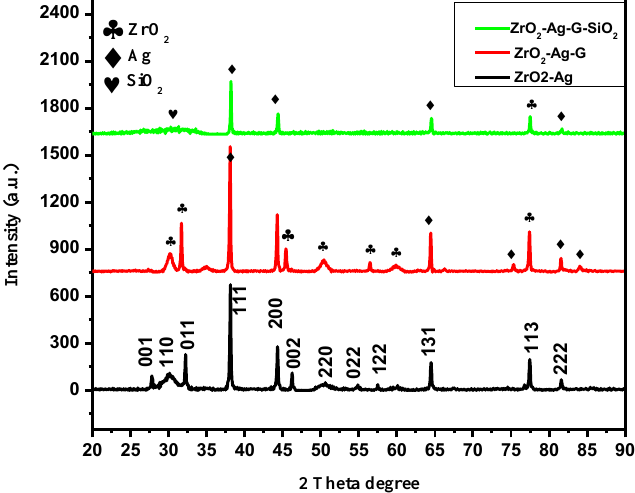
Figure 1. XRD patterns of ZrO 2 -Ag, ZrO 2 -Ag-G and ZrO 2 -Ag-G-SiO 2 . The XRD patterns of the nanoparticles give the major 2y peak values at 25.6, 30.2, 32.9, 38.5, 44.6, 46.2, 50.2, 54.5, 55.2, 63.8, 76.4, and 84.5 in accordance with monoclinic zirconia. All diffraction peak values matched with the international standard file (JCPDS 37-1484). After modification, Ag nanoparticles could be indexed based on pure silver ox- ide having the symmetry of face center cubic. The peaks designated to the planes with the hkl values of 38.5 (111), 63.8 (131), 74.39 (220), and 80.58 (311), respectively, are the same with the XRD pattern of the (JCPDS 65-2871). After modification with SiO 2 the ZrO 2 -Ag- G-SiO 2 all diffraction peaks along the (JCPDS 39-1425), affirming the crystalline nature of the samples.